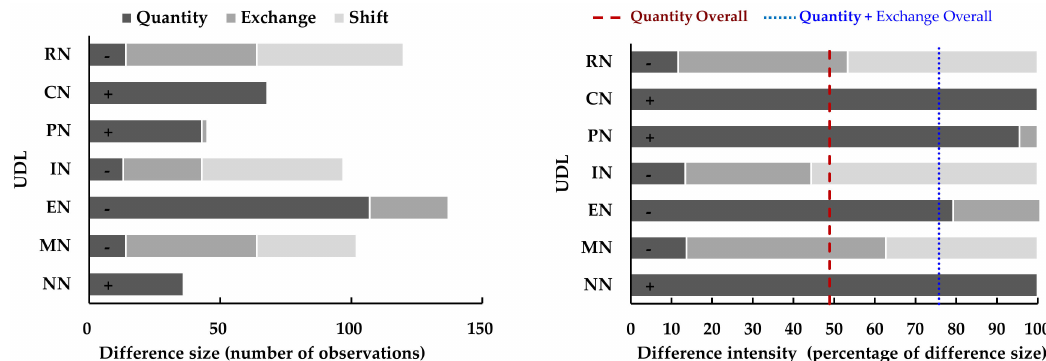
Figure 7. ( left ) Size and ( right ) intensity of differences for Table 3. A positive sign in the quantity disagreement denotes the number of the functional zones in a prediction is greater than in the field survey; a negative sign denotes the number of the functional zones in a prediction is less than in the field survey.